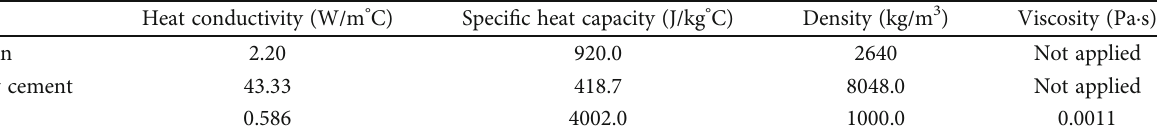
Table 2: Thermal properties for the case